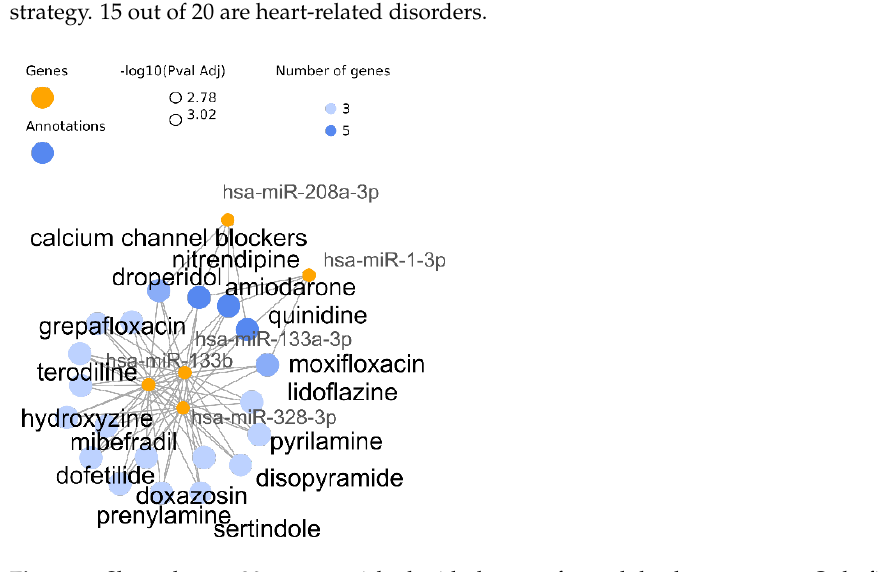
Figure 3. Show the top 20 terms enriched with the transformed database strategy. Only five